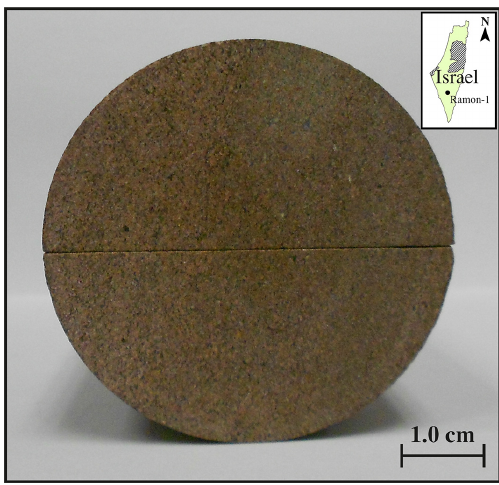
Figure 1. Top view of the fractured Zenifim Sandstone with a di- ameter of 5.0cm and a length of 6.7cm.